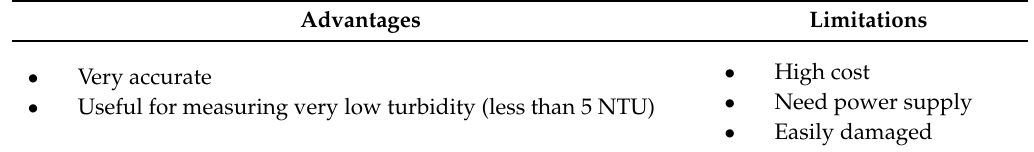
Table 7. Advantages and limitations of